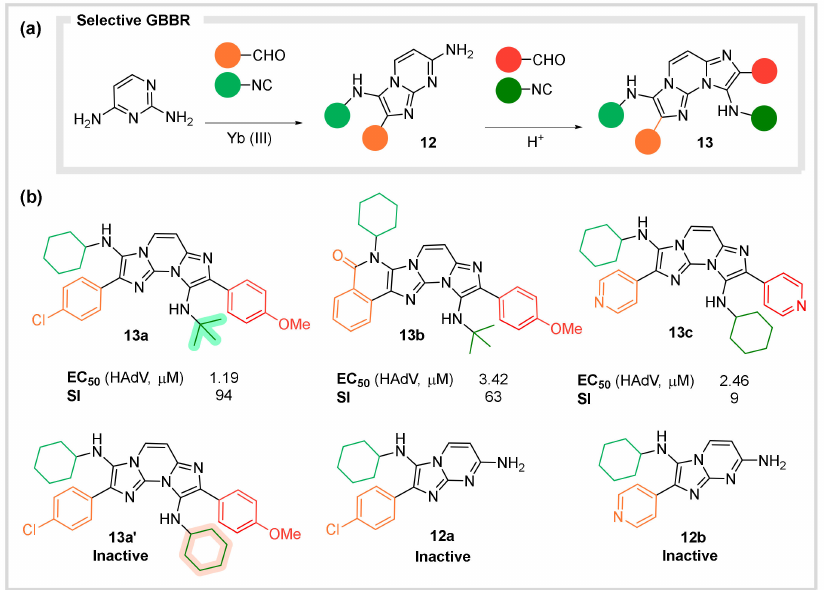
Figure 6. GBBR approach to antivirals. ( a ) Selective GBBRs upon diaminoazines. ( b ) Antiviral activity of the representative GBBR compounds against human